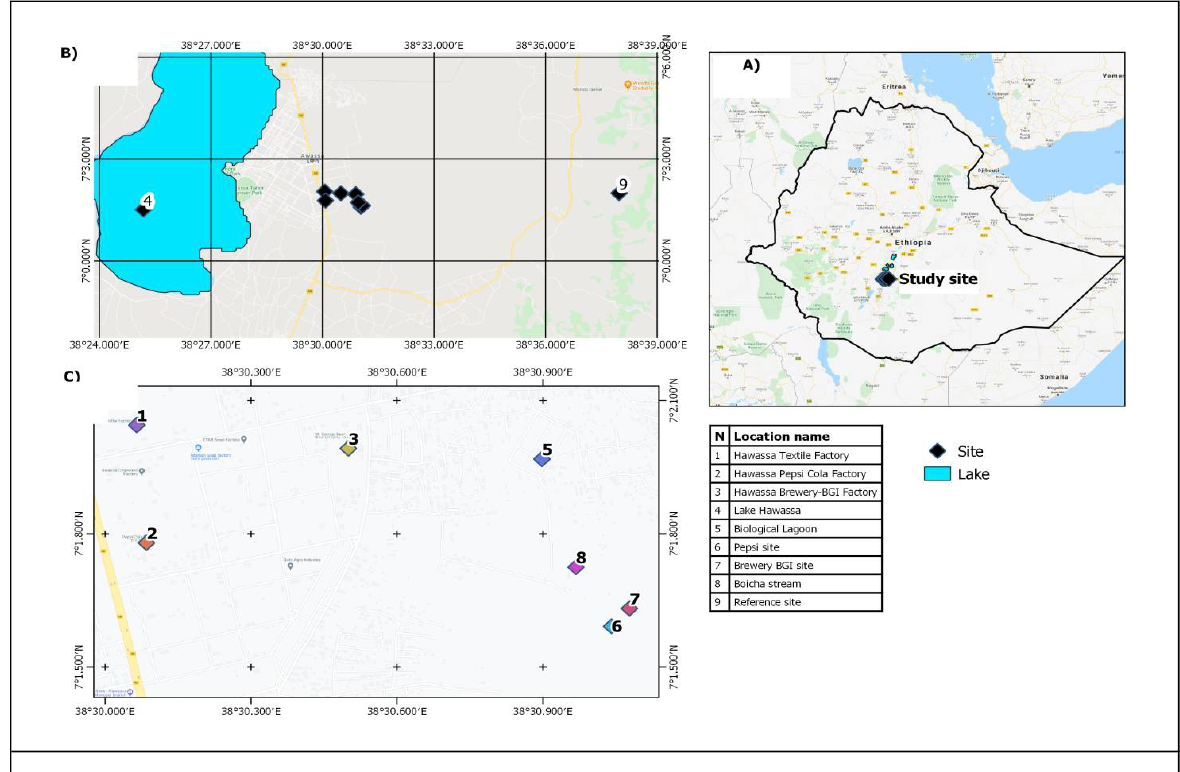
Figure 1: Map of Hawassa industrial zone with sampling